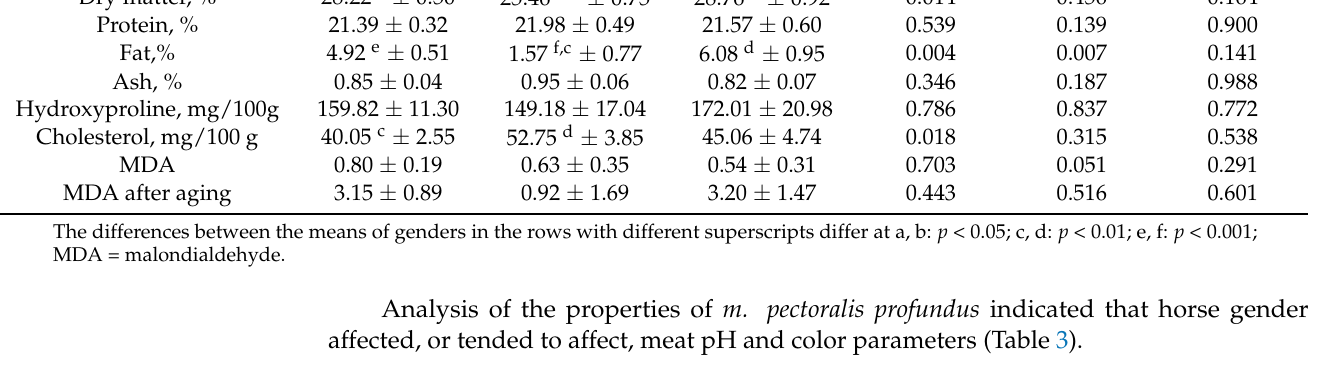
Table 3. Effects of horse gender, age and carcass weight on meat quality parameters.